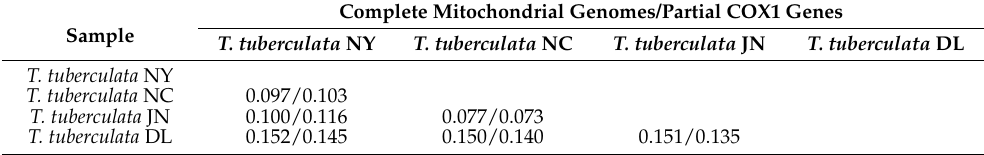
Table 4. Corrected pairwise distance of the complete mitochondrial genomes (left) and partial COX1 genes (right) of T. tuberculata from four